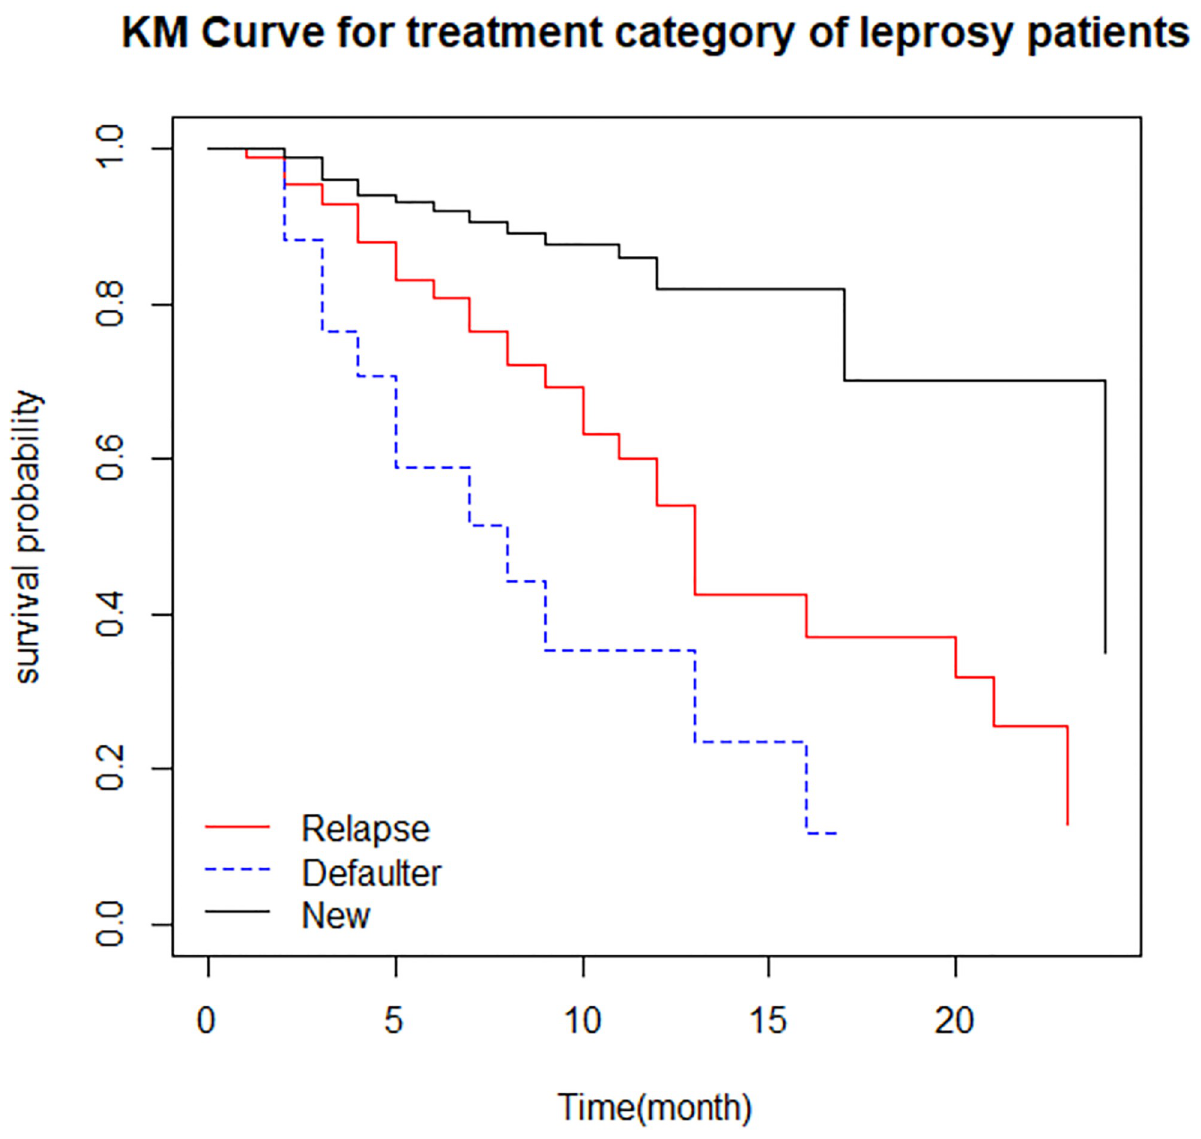
Fig 3. The survival function by treatment category of leprosy patients. https://doi.org/10.1371/journal.pone.0271883.g003 who were new for treatment as compared with patients in the relapse category. Duration of the disease before starting the treatment for a patient was another factor that significantly predicts having some disability during treatment. The hazard ratio for the disease duration of a patient was (HR = 1.013). This implies, that the hazard of experiencing some disability was signifi- cantly increased by 1.3% (p-value = 0.036) for a unit increase in the duration of disease before treatment, keeping all variables constant. In addition, there was a reduced risk of experiencing some disability by 36% for patients who do not have a sensory loss at diagnosis. The HR was 0.361[0.173, 0.751]and since the confidence interval did not include one and the p-value was very small (P = 0.006) indicating that loss of sensation was a significant factor to determine the disability from leprosy at 5% level of significance (Table 8).